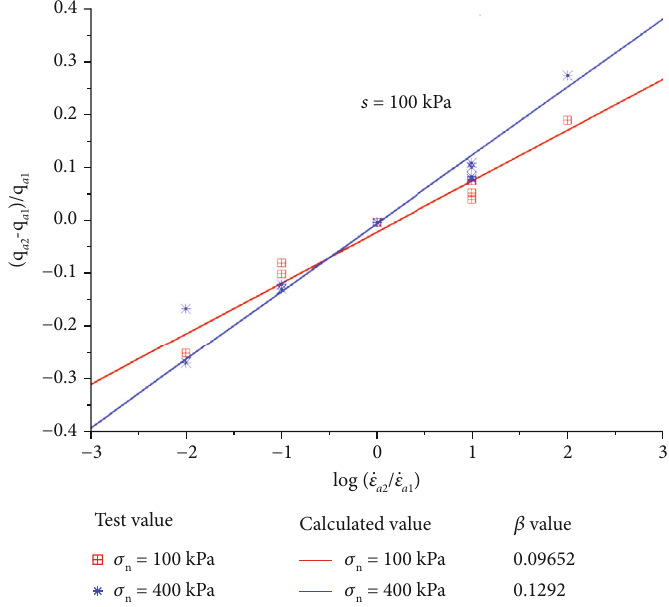
Figure 13: β value of reticulate red clay with di ff erent con fi ning pressure ( s = 100 kPa ).